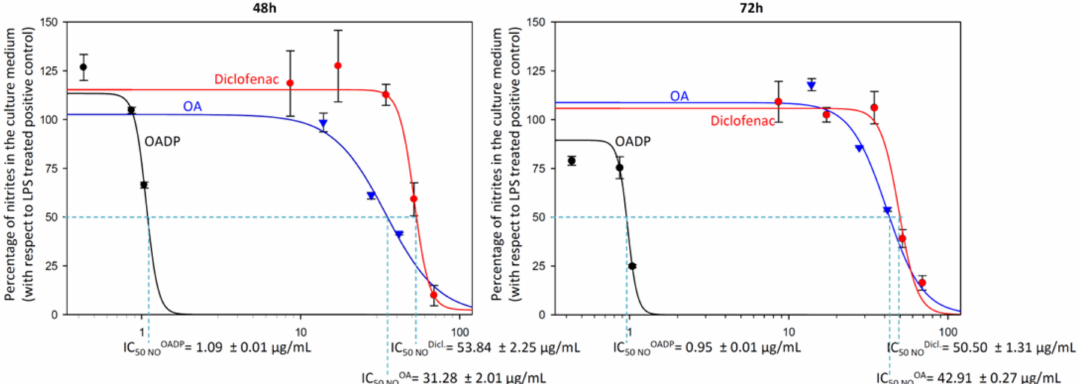
Figure 3. Sigmoidal curves of the effect of OADP (black), OA (blue) and diclofenac (red) on nitrite release in RAW 264.7 cells, after treatment with the compounds for 48 h and 72 h. Data represent the mean ± S.D. of at least two independent experiments performed in